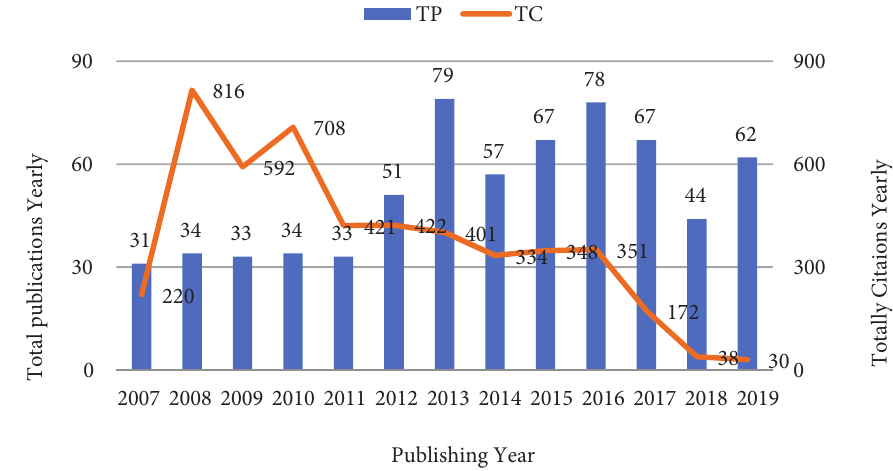
Figure 1. Trend of Total publications and Total Citations